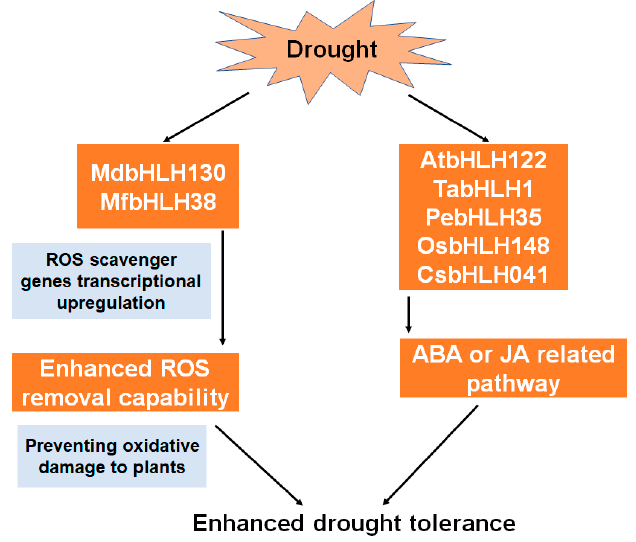
Figure 1. Model of the roles of bHLHs in drought